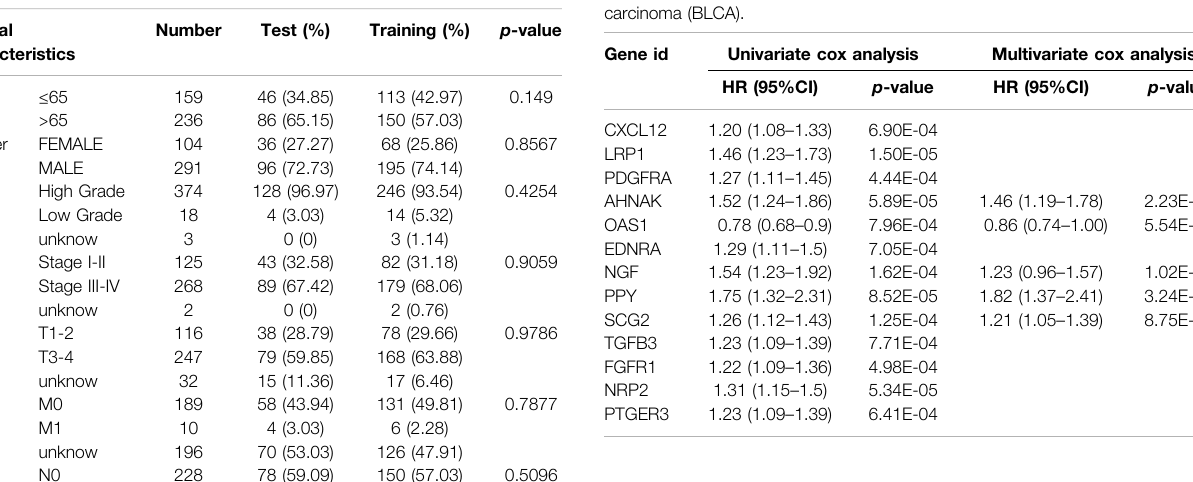
TABLE 1 | Comparison of clinical characteristics between the training and test sets.